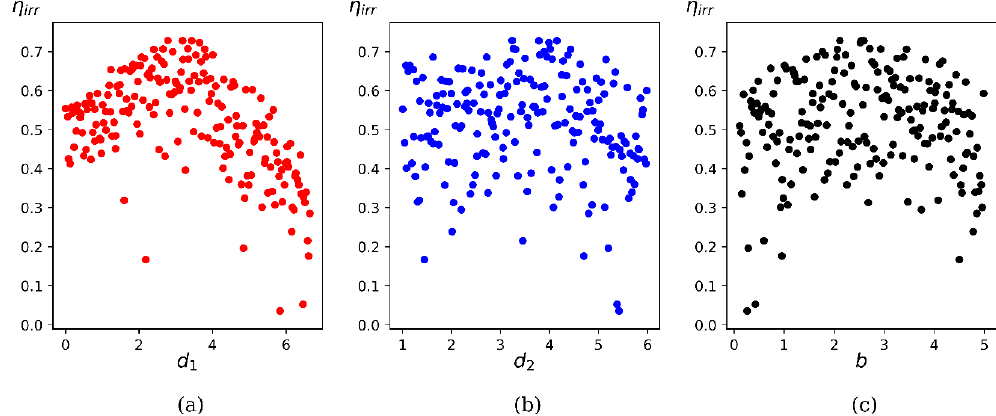
Figure 10. Variation of conversion efficiency of a U-OWC versus input feature: ( a ) barrier height, ( b ) submergence depth of a chamber wall, and ( c ) barrier distance at T E = 5 s in irregular